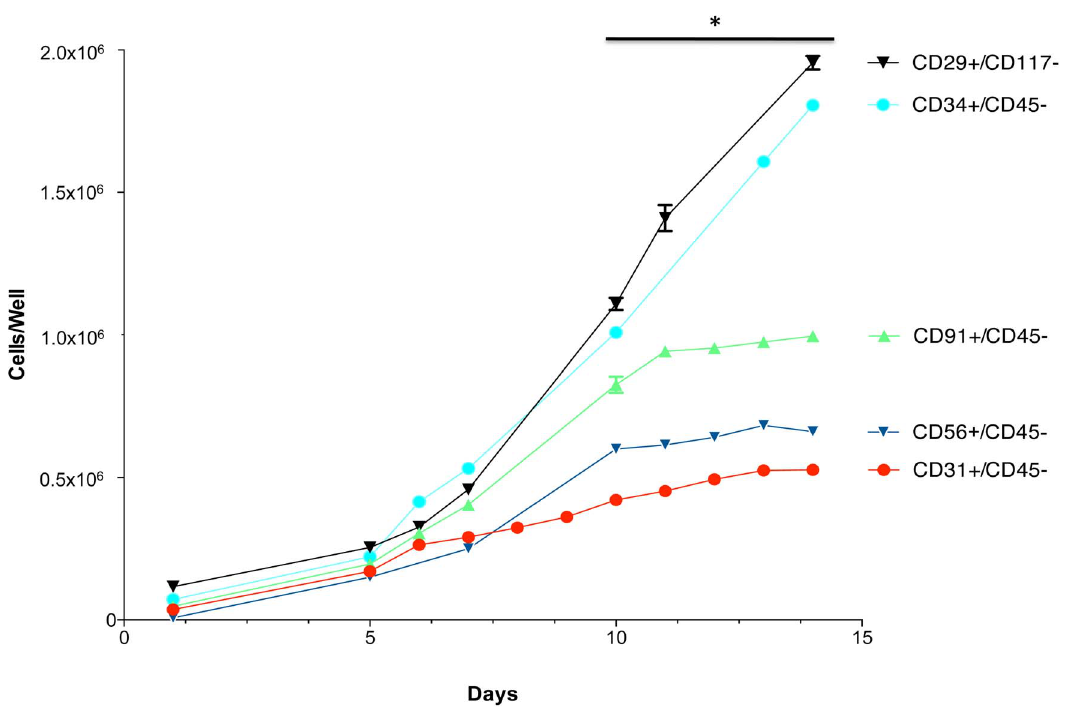
Fig. 5. Growth characteristics of CD29, CD31, CD34, CD56 and CD91 positive cells. Flourescent-conjugated antibodies to CD29, CD31, CD34, CD56 and CD91 were used to separately sort and subculture cells form collagenase 2 digested human muscle. The cells were seeded at 1 6 10 5 cells per well in 6- well plates on day 0 and cultured for an additional two weeks. The graph indicates the cell number on the indicated days (mean ¡ SEM, n 5 8). A significant difference is noted (*) between cell growth number for replicates between 10 and 15 days of growth for all five cell populations (Mann Whitney U test, p #